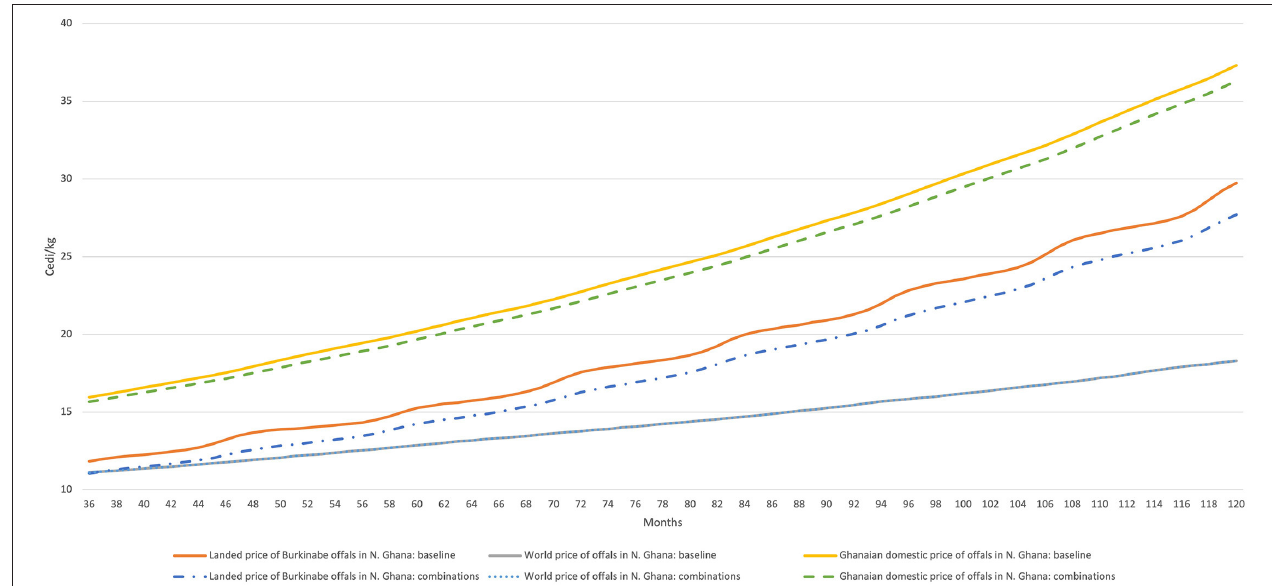
FIGURE 7 | Evolution of offal prices in Burkina Faso, Ghana, and world markets (Cedi/kg) under a combination of strategies—focus on Northern Ghana. Model